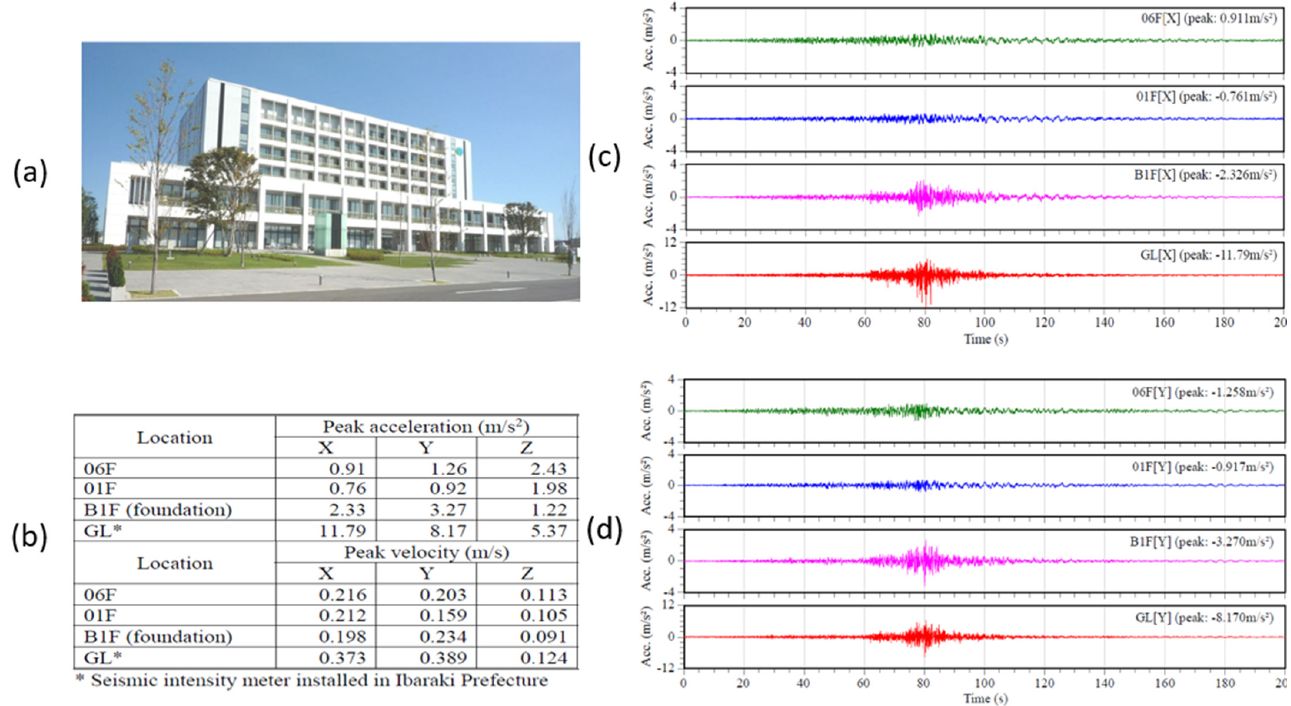
Figure 17. ( a ) Tsukuba City Hall. ( b ) Reduction of PGA and PGV from recorded events. ( c ) Acceleration waveform in X direction. ( d ) Acceleration waveform in Y Direction [63] .